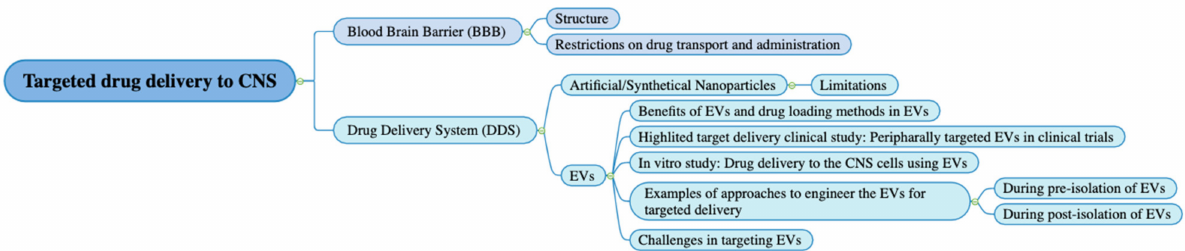
Figure 1. A schematic coverage of this review. We first discuss a brief explanation of the structure of the blood brain barrier (BBB) and its effect on drug permeability followed by the limitations of the current nanoformulation in drug delivery. Afterwards, we introduce EVs for targeted drug delivery, in which we list several clinical studies on targeted delivery in the peripheral system. Furthermore, we focus on engineering extracellular vesicles (EVs) for targeted delivery in the central nervous system (CNS) with four examples that are discussed in detail. Finally, we provide some limitations regarding an EV-based drug delivery system (DDS) during